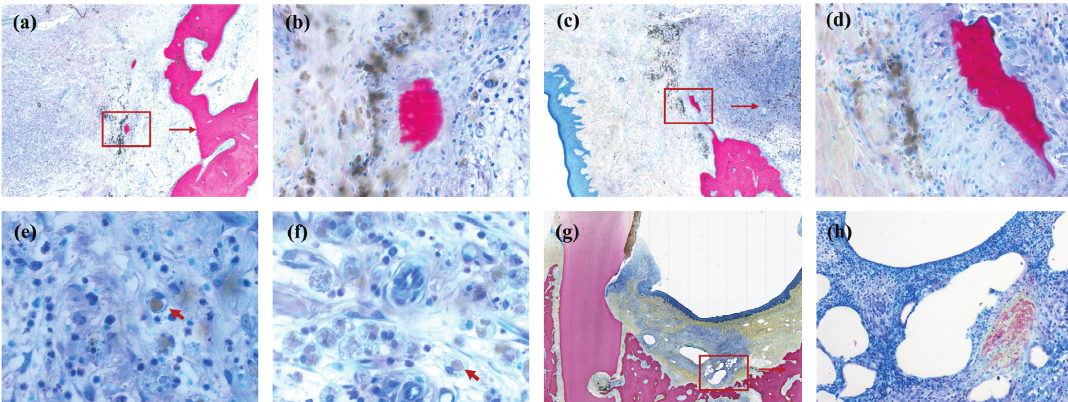
Figure 7: Histology of MAR-Gide degradation. (a–d) “Island-shaped” new bone is formed accompanied with the degradation products of MAR-Gide. (a, c) 25x magnification; (b, d) 200x magnification. (e, f) Degradation particles of MAR-Gide are “swallowed up” by monocytes (400x magnification). (g, h) Gas cavities are found in only one section in the group MG-3 m, which are divided into compartments surrounded with fibrotic